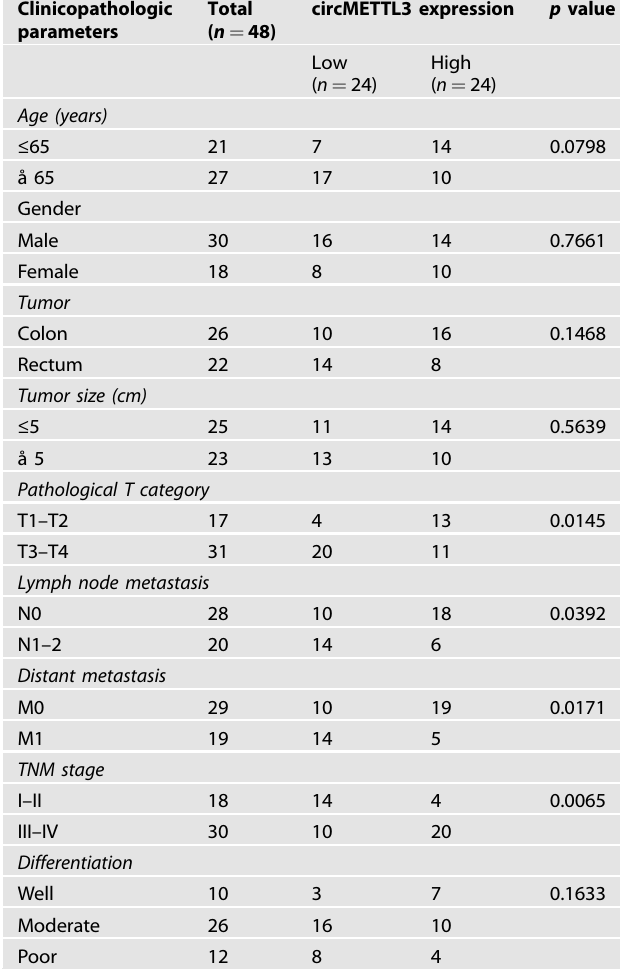
Table 1. Clinicopathological characteristics of CRC patients ( n = 48). Feature